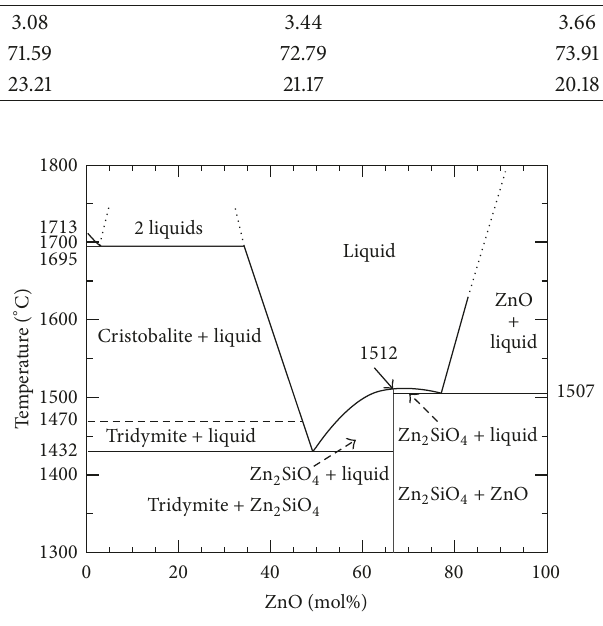
Figure 2: Binary system of ZnO–SiO 2 system